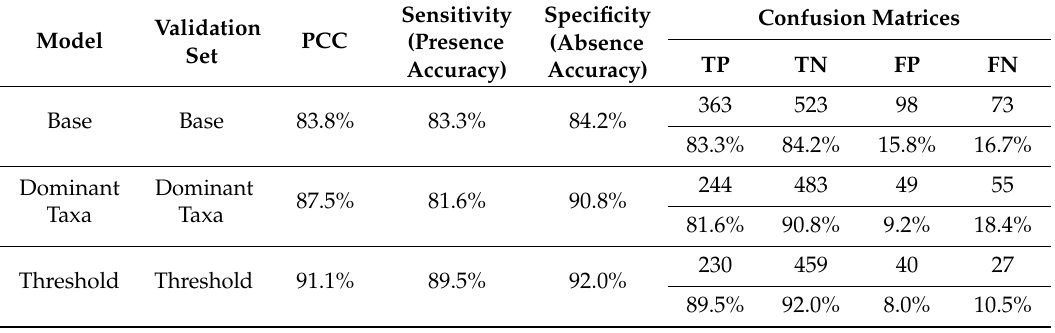
Table 2. Point validation metrics comparing percent correctly classified (PCC), sensitivity, and specificity between all models, with associated confusion matrices. Cross-validation between models and associated metrics located in Appendix A Table A2.